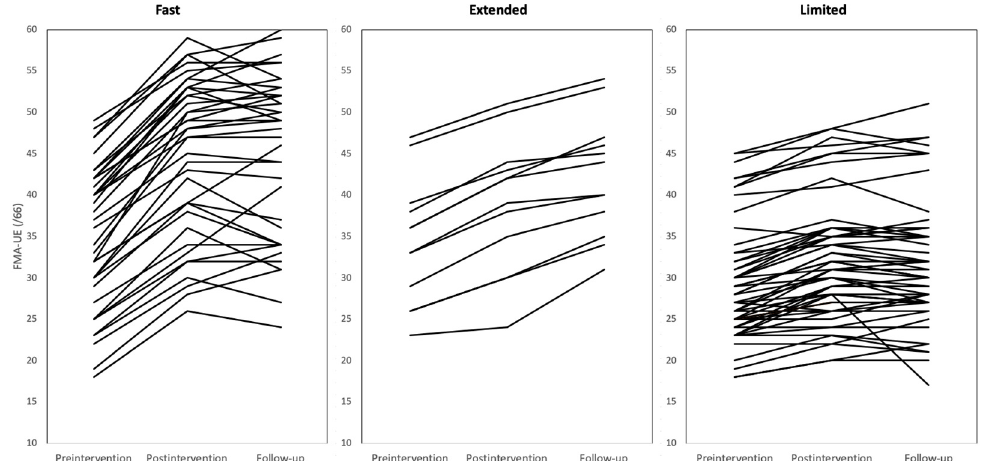
Figure 1. Line plots showing recovery trajectories by group. The x-axis shows time and the y-axis shows Fugl–Meyer Assessment-Upper Extremity subscale (FMA-UE) scores. The left plot shows the fast recovery group (n = 38), the center plot shows the extended recovery group (n = 12), and the right plot shows the limited recovery group (n = 55). Table 1. Demographic and stroke-related characteristics.